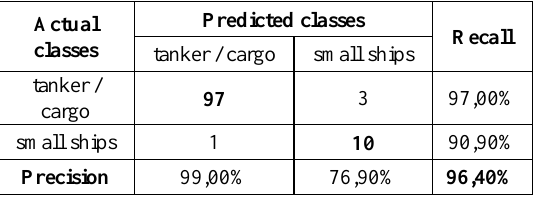
Table 3. Confusion matrix for the first stage of the hierarchical classification.